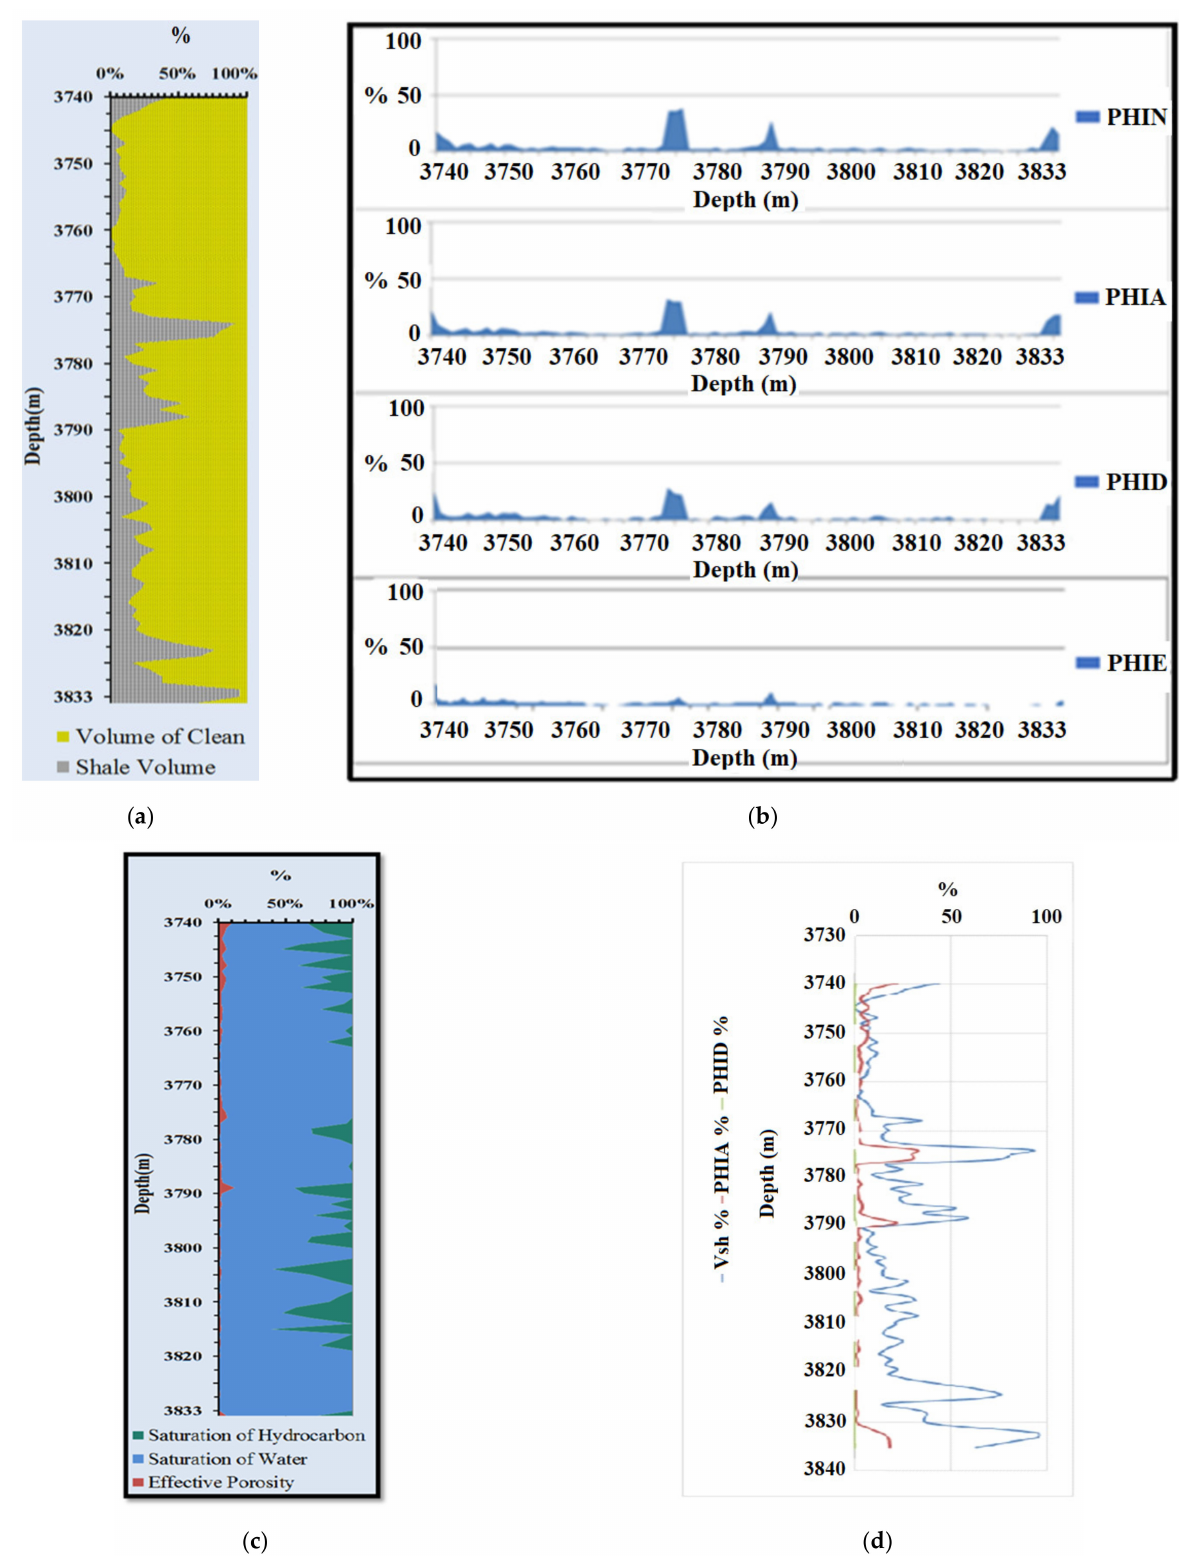
Figure 8. ( a ) Relationship between the volume of shale and volume of clean with respect to the depth of zone 1; ( b ) rela- tionship between neutron porosity, average porosity, density porosity, and effective porosity of zone 1; ( c ) Relationship between the saturation of water and saturation of hydrocarbon for zone 1; ( d ) relationship between the volume of shale (Vsh), average porosity (PHIA), and average density porosity (PHID) of zone